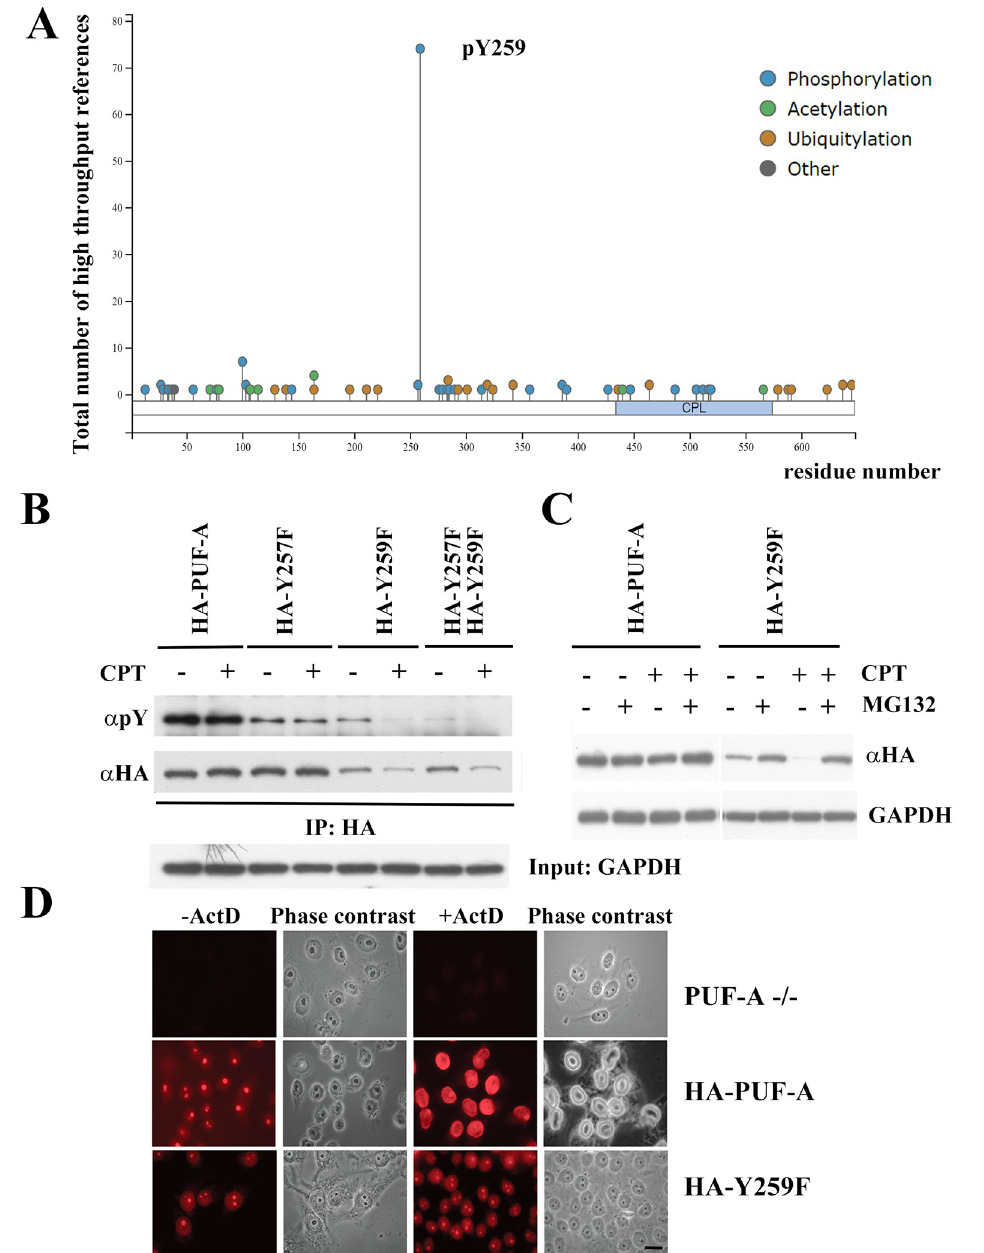
Fig 4. Phosphorylation of PUF-A on Y259. (A) Identification of phosphorylated PUF-A at Y259 using PosphoSitePlus database. (B) HA-PUF-A, HA-PUF-A Y257F (HA-Y257F), HA-PUF-A Y259F (HA-Y259F) and HA-PUF-A Y257FY259F (HA-Y257F/HA-Y259F) transfected HEK293T cells were incubated with camptothecin (CPT, 5 μ M) for 3 hr. Cell extracts were immunoprecipitated using anti-HA agarose and then immunoblotted with indicated antibodies. All Western blots were processed in identical conditions and cropped from S4 Fig. (C) HA-PUF-A and HA-PUF-A Y259F transfected HEK293T cells were incubated with MG132 for 3 h prior to CPT treatment for 16 h. Immunoblotting was carried out with indicated antibodies. All Western blots were processed in identical conditions and cropped from S4 Fig. (D) HA-PUF-A and HA-PUF-A Y259F were transfected into PUF-A ablated HeLa cells. Cells were exposed to actinomycin D (ActD, 1 μ g/ μ l) for 1 h and then immunofluorescence staining was conducted. Scale bar, 10 μ m.